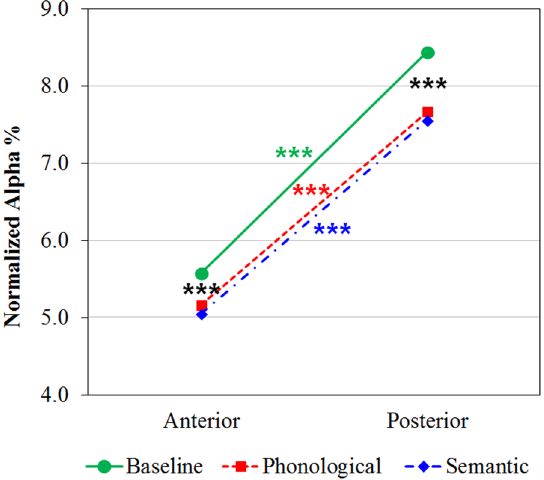
Figure 3. Alpha band analysis: significant two-way Task by Region interaction. Alpha distributions to resting state, baseline condition (green line), phonological (dotted red line) and semantic tasks (dotted-spotted blue line) are shown for anterior and posterior brain regions, regardless of group. Asterisks: significant (p < 0.05) post hoc comparisons.